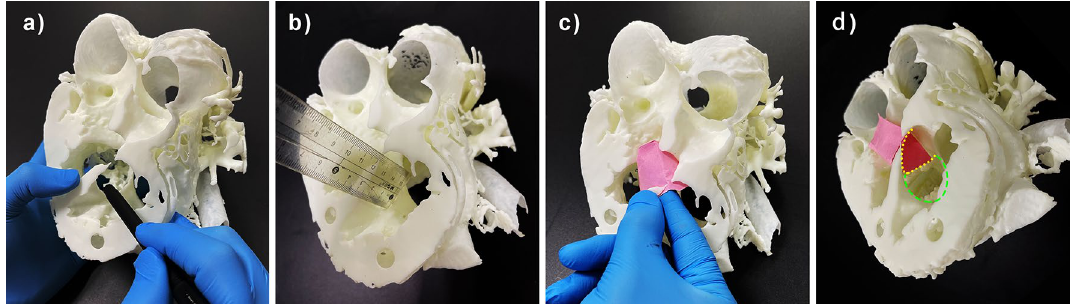
Figure 6. Study of the operation plan using the myocardial model in the case of DORV. ( a ) Exploration of intracardiac structures and the location of the VSD. ( b ) Direct measurement of key dimensions of the VSD. ( c ) Establishment of an internal channel from the VSD to the root of the aorta. ( d ) Simulation and presentation of the surgical plan. Yellow area: location of the intraventricular tunnel patch. Green area: location of the patch for the VSD. DORV: double outlet right ventricle; VSD: ventricular septal